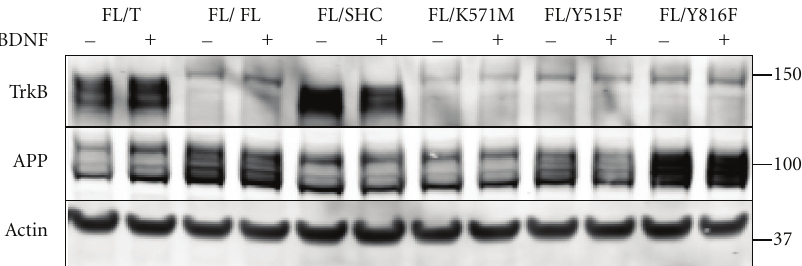
Figure 7: Cotransfection of TrkB FL with isoforms and mutants alters the TrkB FL e ff ects on APP full-length. TrkB FL transfection increases APP FL levels compared to when TrkB FL is cotransfected with TrkB T, TrkB SHC or TrkB K571M. APP FL levels did not significantly di ff er between TrkB FL transfected cells and TrkB FL cotransfection with TrkB Y515F or TrkB Y816F. 24 hours BDNF treatment of cotransfected cells did not significantly alter APP FL levels compared to cotransfected but nontreated